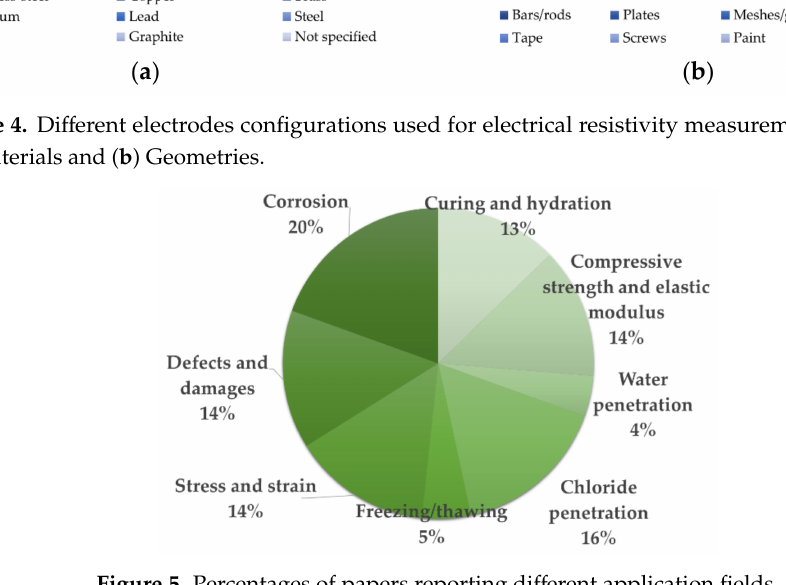
Figure 5. Percentages of papers reporting di ff erent application